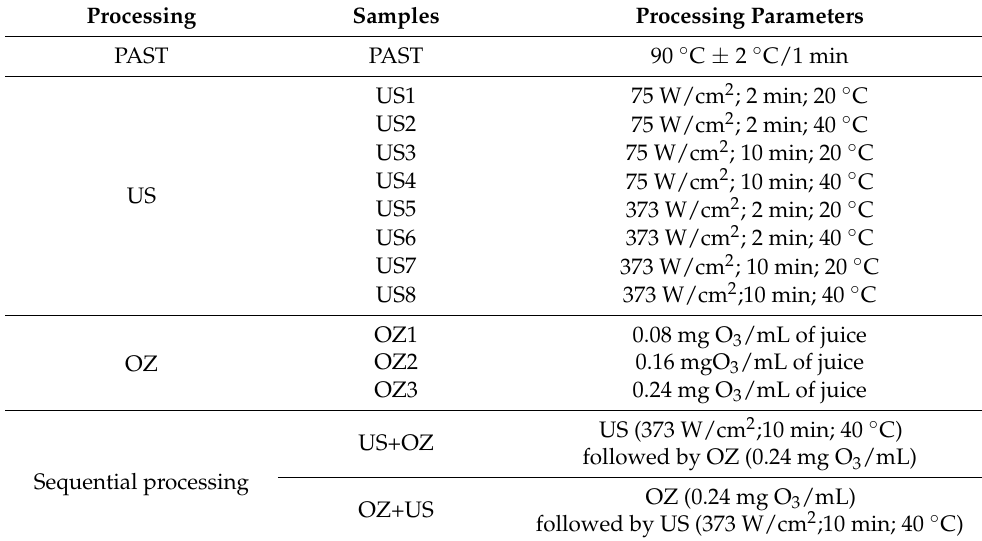
Table 1. Experimental parameters applied to thermal and non-thermal processing of cashew apple